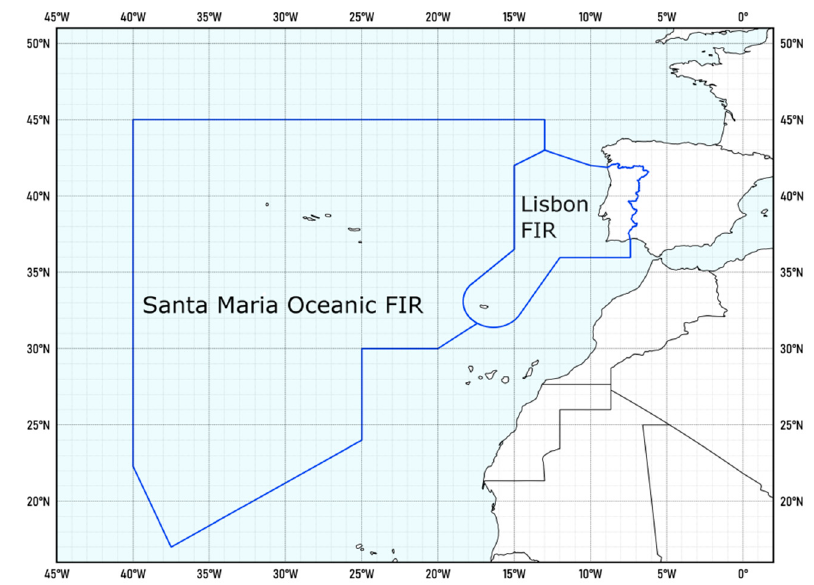
Figure 1. Portuguese flight information regions.